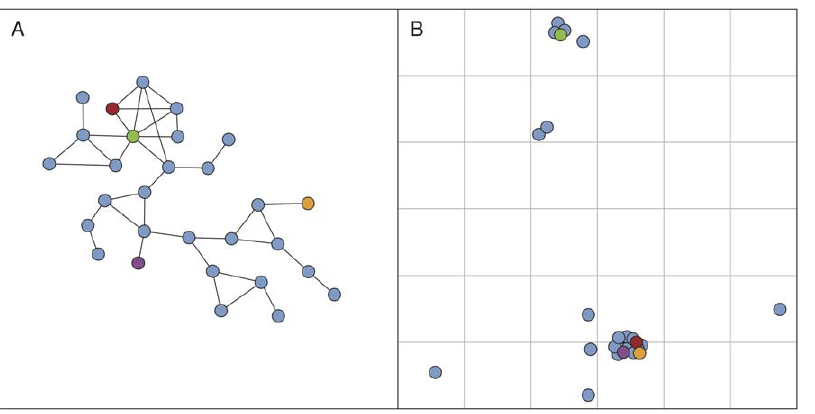
Figure 1. Visualization of a community in the mobile phone network. This juxtaposition of ( A ) the topological structure and ( B ) the geographical structure demonstrates the interplay of these two dimensions. The purple and orange nodes are geographically close, but topologically they lie at five degrees of separation. In contrast, the red and green nodes are connected to each other, and also share several neighbors, yet they are geographically separated by a large distance. Overlapping nodes in (B) have been moved slightly for visual clarity.